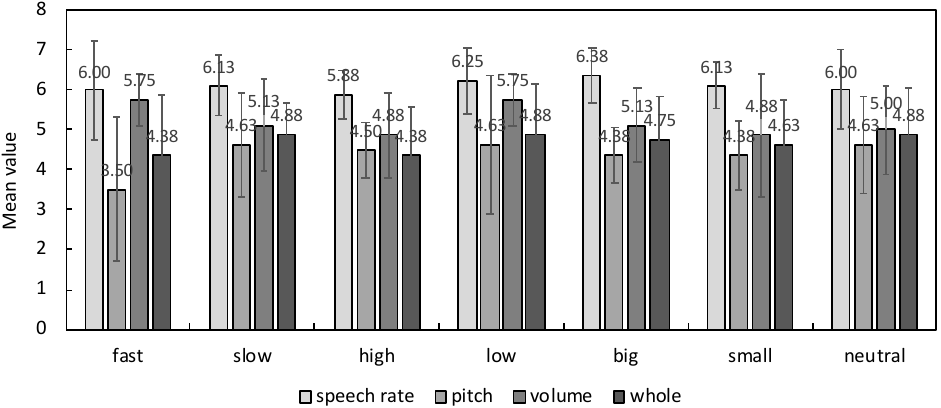
Figure A3. Mean value of subjective responses.